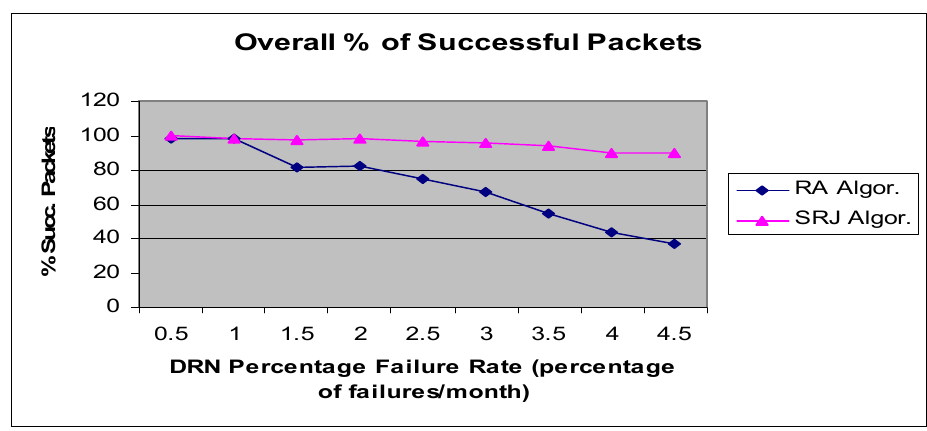
Figure 12. Simulation results for the hierarchical acoustic wireless sensor network. Percentage of successfully transmitted packets. NUM_DRN_PER_DDN =